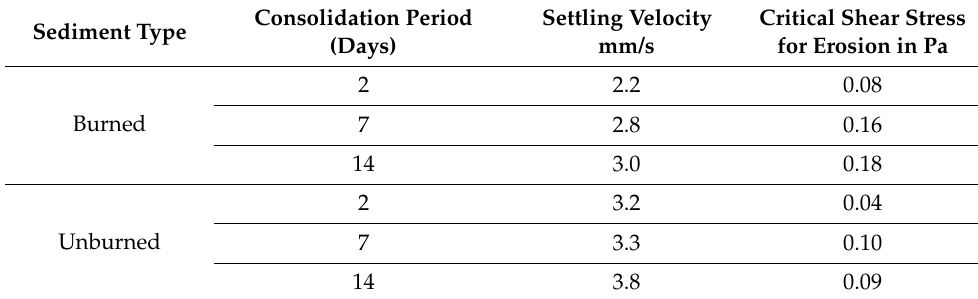
Table 4. Critical shear stresses for erosion and settling velocity of fine sediment from the Castle River watershed (Source: Stone et al. [62]).